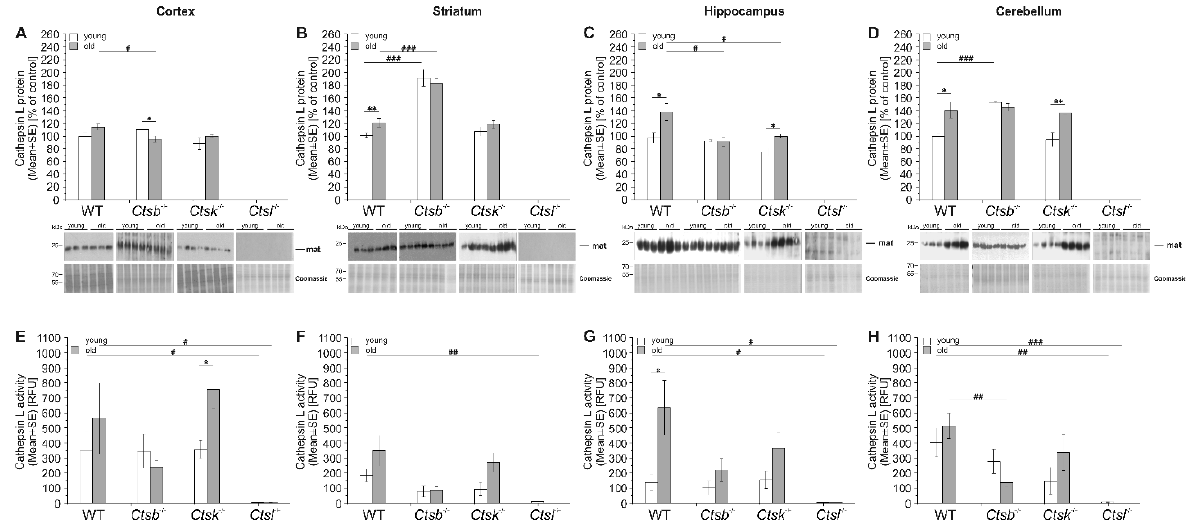
Figure 6. Status of cathepsin L protein and activity levels in the CNS of young and aged cathepsin- deficient mice compared to WT controls. ( A – D ) Densitometry analysis of immunoblots prepared from lysates of cerebral cortex, striatum, hippocampus, and cerebellum of young (white bars) and aged (gray bars) WT, Ctsb − / − , Ctsk − / − , and Ctsl − / − mice as indicated. Representative immunoblots are shown in the lower panels; lanes represent separate individuals. Coomassie-stained gels serve as a loading control. There were age-dependent increases in cathepsin L protein in striatum, hippocampus, and cerebellum of aged WT animals and in hippocampus and cerebellum of aged Ctsk − / − mice. ( E – H ) Cathepsin L activity (measured in relative fluorescence units (RFU)), as determined by cleavage of Z-Phe-Arg-AMC at pH 5.5. Cathepsin L activity was increased in the cortex of aged Ctsk − / − mice. Levels of significance between different ages are denoted as * or # for p < 0.05; ** or ## for p < 0.01; *** or ### for p <